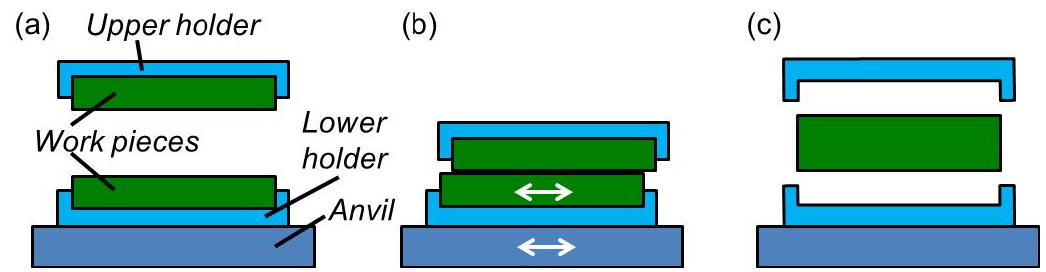
Figure 1. Schematic drawing of friction welding: ( a ) before the process, ( b ) rubbing of the work pieces, (c) removing of the welded parts.